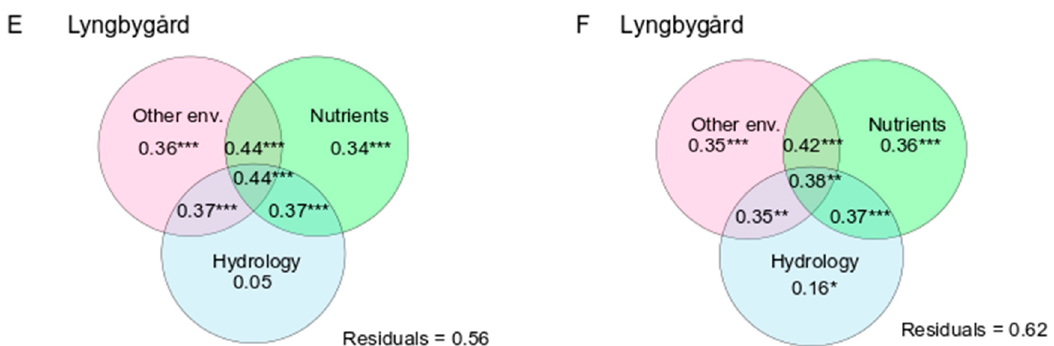
Figure 5. Partial redundancy analysis (pRDA) for quantifying the variation of diatom community composition explained by hydrology (Q med , CV of Q), nutrients (PO 43 − , DIN) and other environmental variables (other env: light, temperature, DOC), their shared contribution and unexplained variance (i.e., Residual). Each subplot represents the studied diatom assemblages as ( A ): epiphyton; ( B ): epilithon; ( C ): epiphyton in Aarhus stream; ( D ): epilithon in Aarhus stream; ( E ): epiphyton in Lyngbygård stream and ( F ): epilithon in Lyngbygård stream. Significance codes: * p < 0.05, ** p < 0.01, *** p < 0.001. All environmental data derived from measurements taken in the period of 21 days before sampling date (Figure 1).